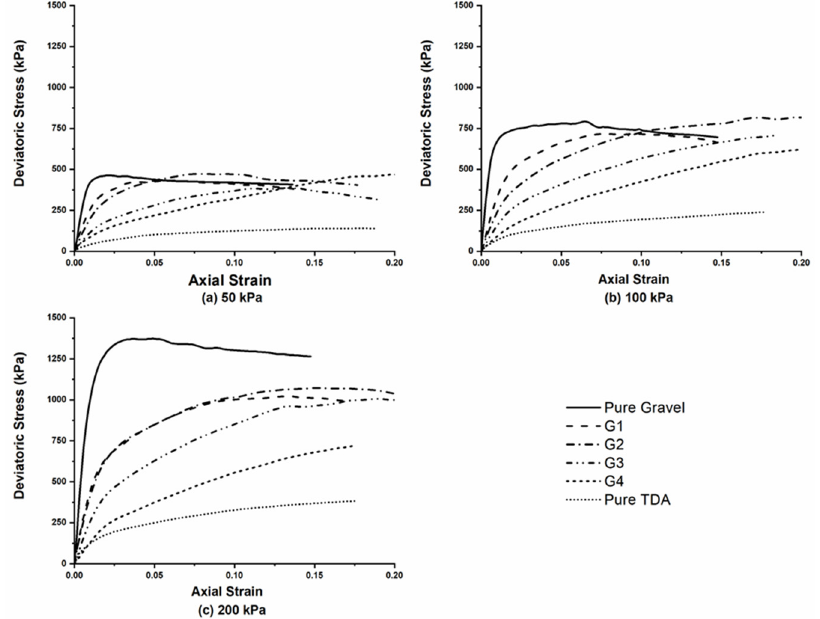
Figure 7. Deviatoric stress versus axial strain for TDA ‐ gravel samples with 0%, 5%, 10%, 20%, 30%, and 100% TDA by weight at confining pressures of 50 kPa, 100 kPa, and 200 kPa.